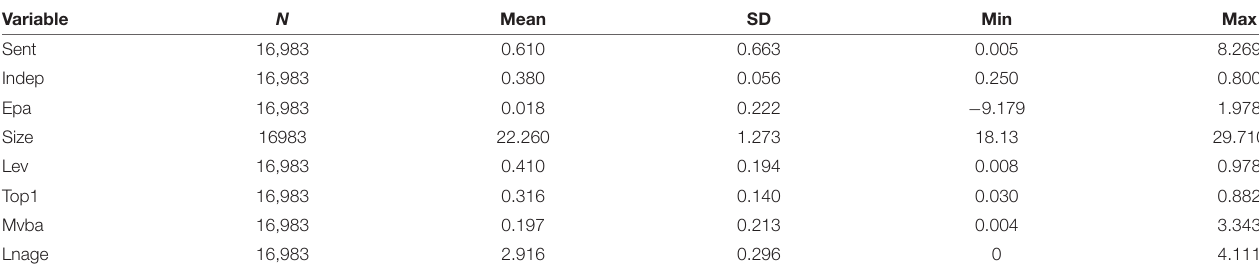
TABLE 3 | The descriptive